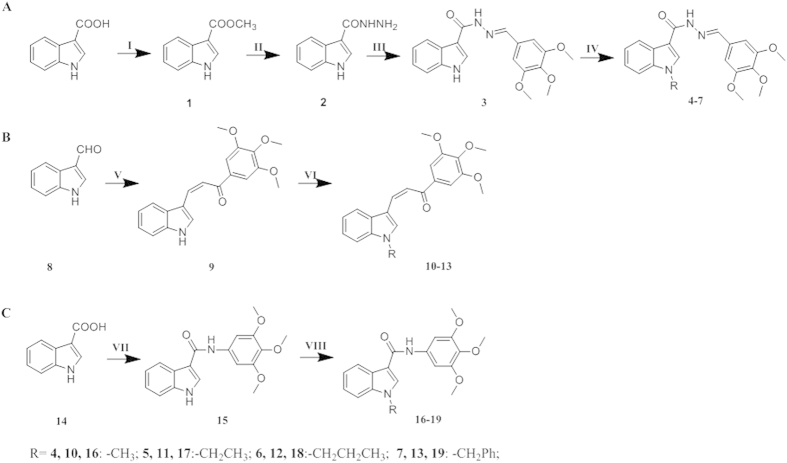
(A) Synthetic route for compounds 4–7. (I) methanol, concentrated sulfuric acid, 65 °C, 12 h; (II) hydrazine hydrate (85%), ethanol, 80 °C, 4–5 h; (III) ethanol, acetic acid, 80 °C, 4–5 h; (IV) NaH, different haloalkanes, THF, 0 °C to room temperature. (B) Synthetic route for compounds 10–13. (I) EtOH, 40% NaOH, 0 °C, 30 min; room temperature, 4 h; (II) NaH, different haloalkanes, THF, 0 °C to room temperature. (C)Synthetic route for compounds 16–19. (VII) EDC∙HCl, HOBt, rt, 8–10 h. (VIII) NaH, different haloalkanes, THF, 0 °C to room temperature.